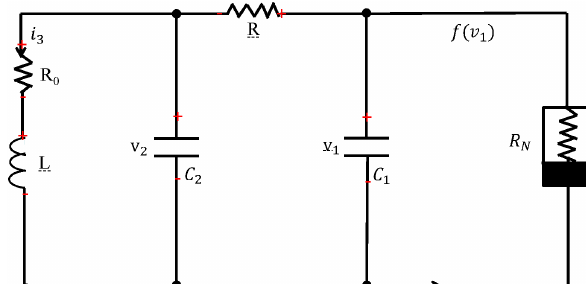
Figure 3. Diagram of a nonlinear Chua circuit.